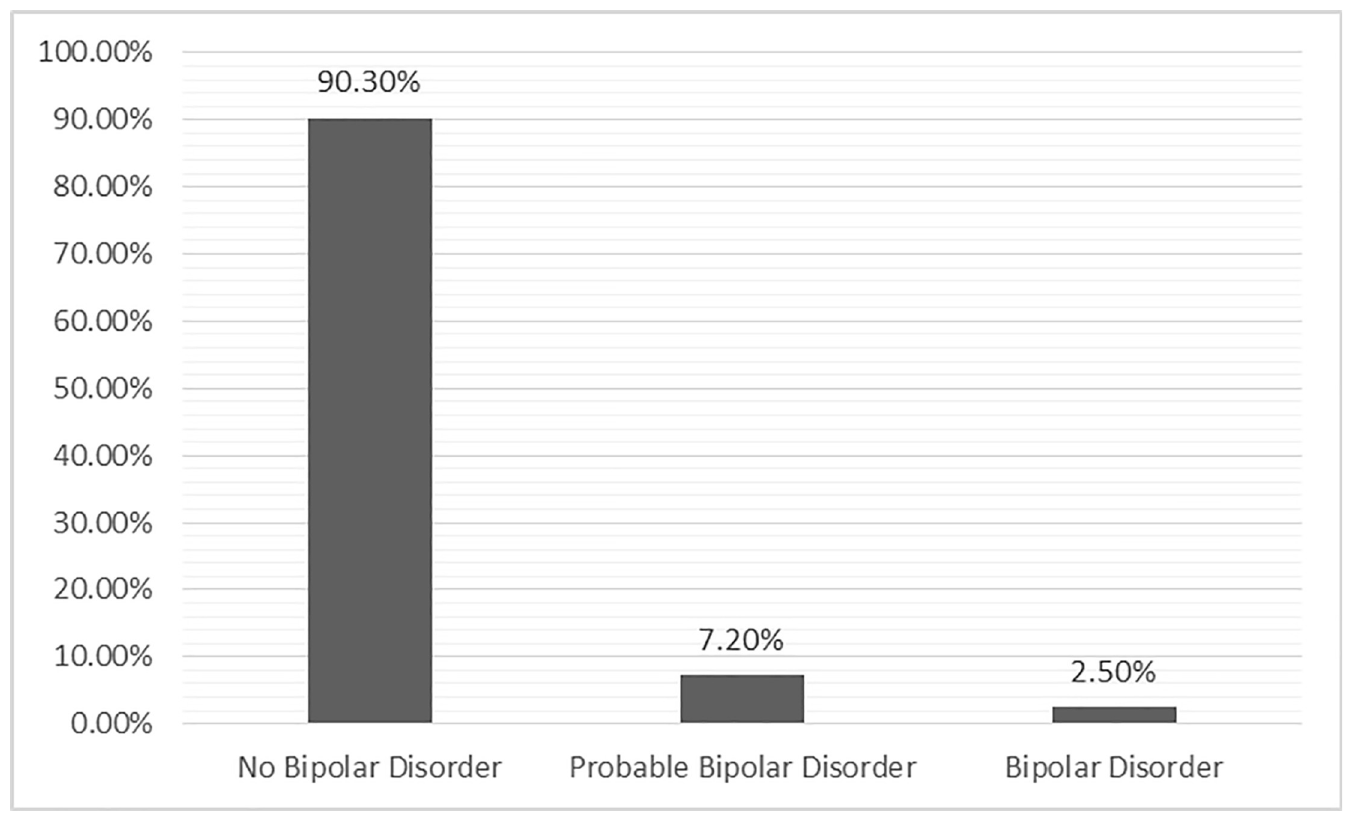
Fig 2. Prevalence of BPD among married women in Rajshahi city, Bangladesh.